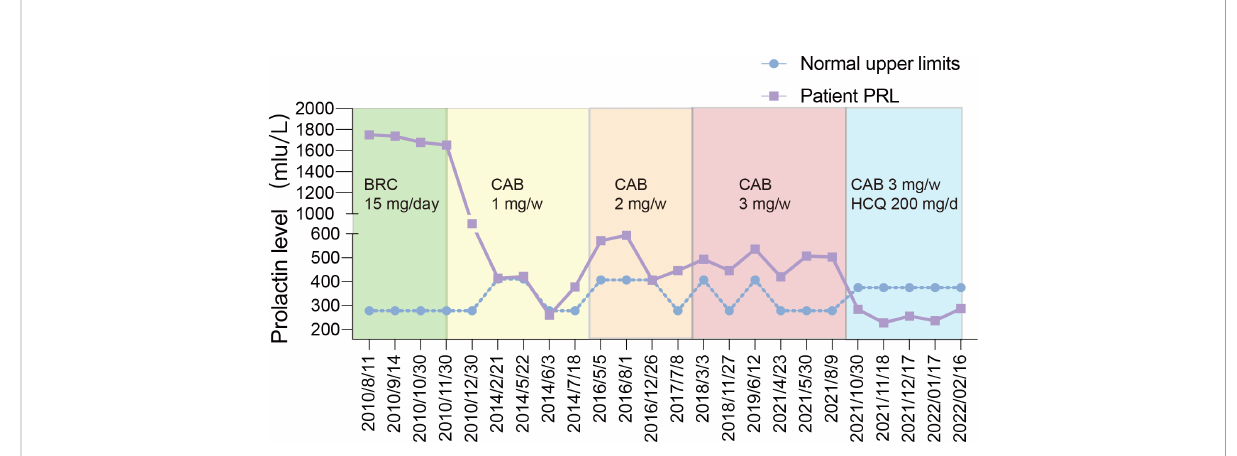
FIGURE 2 The blue line represented his PRL level in the 12-year following up and the purple line represented the upper limit of PRL normal range according to the hospitals where the blood was